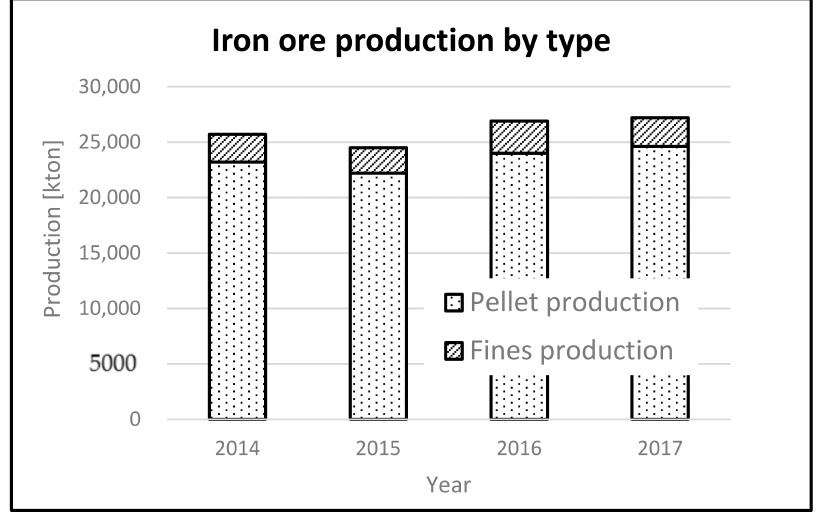
Figure 6. Iron ore production by type. Data from